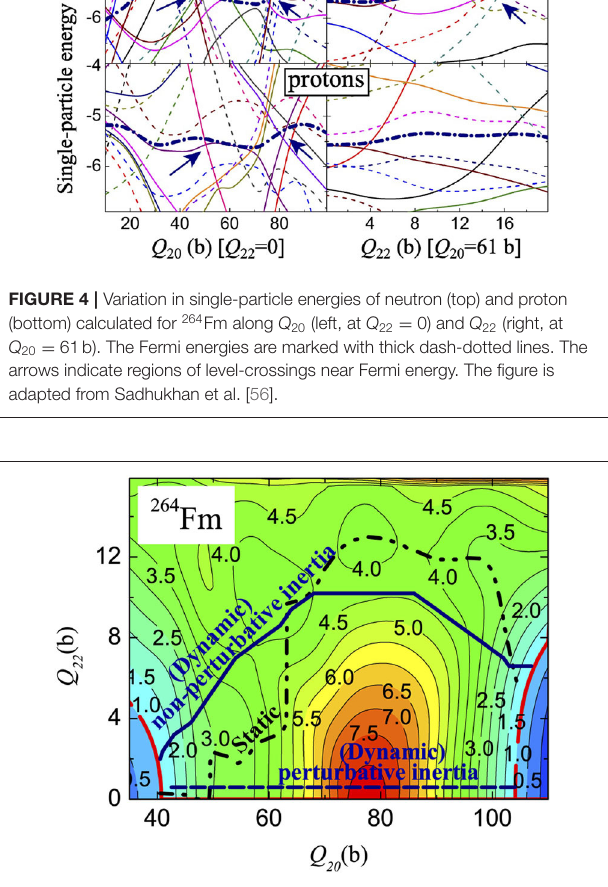
FIGURE 5 | Minimum-action (or most-probable) fission paths of 264 Fm [56], calculated for M C (solid line) and M C p (dashed line) using the DPM technique. cranking inertia using DMP technique. The static pathway is shown by the dash-dotted line. The loci of turning points are marked by thick solid lines. The PES (in MeV) is plotted for reference. The figure is modified from Sadhukhan et al. [ 56].